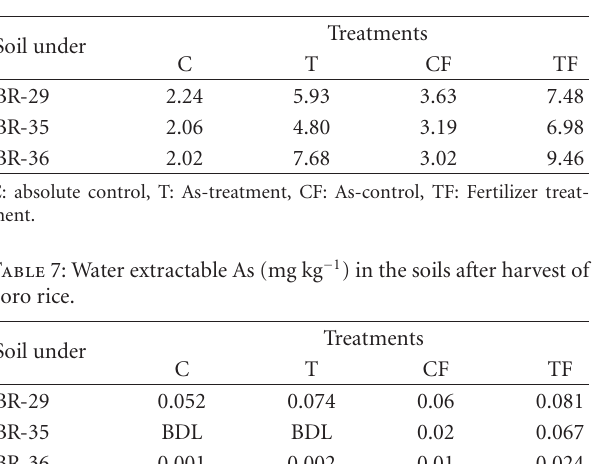
Table 6: Total As content (mg kg − 1 ) in the soils after harvest of the boro rice. Treatments Soil under C T CF TF BR-29 2.24 5.93